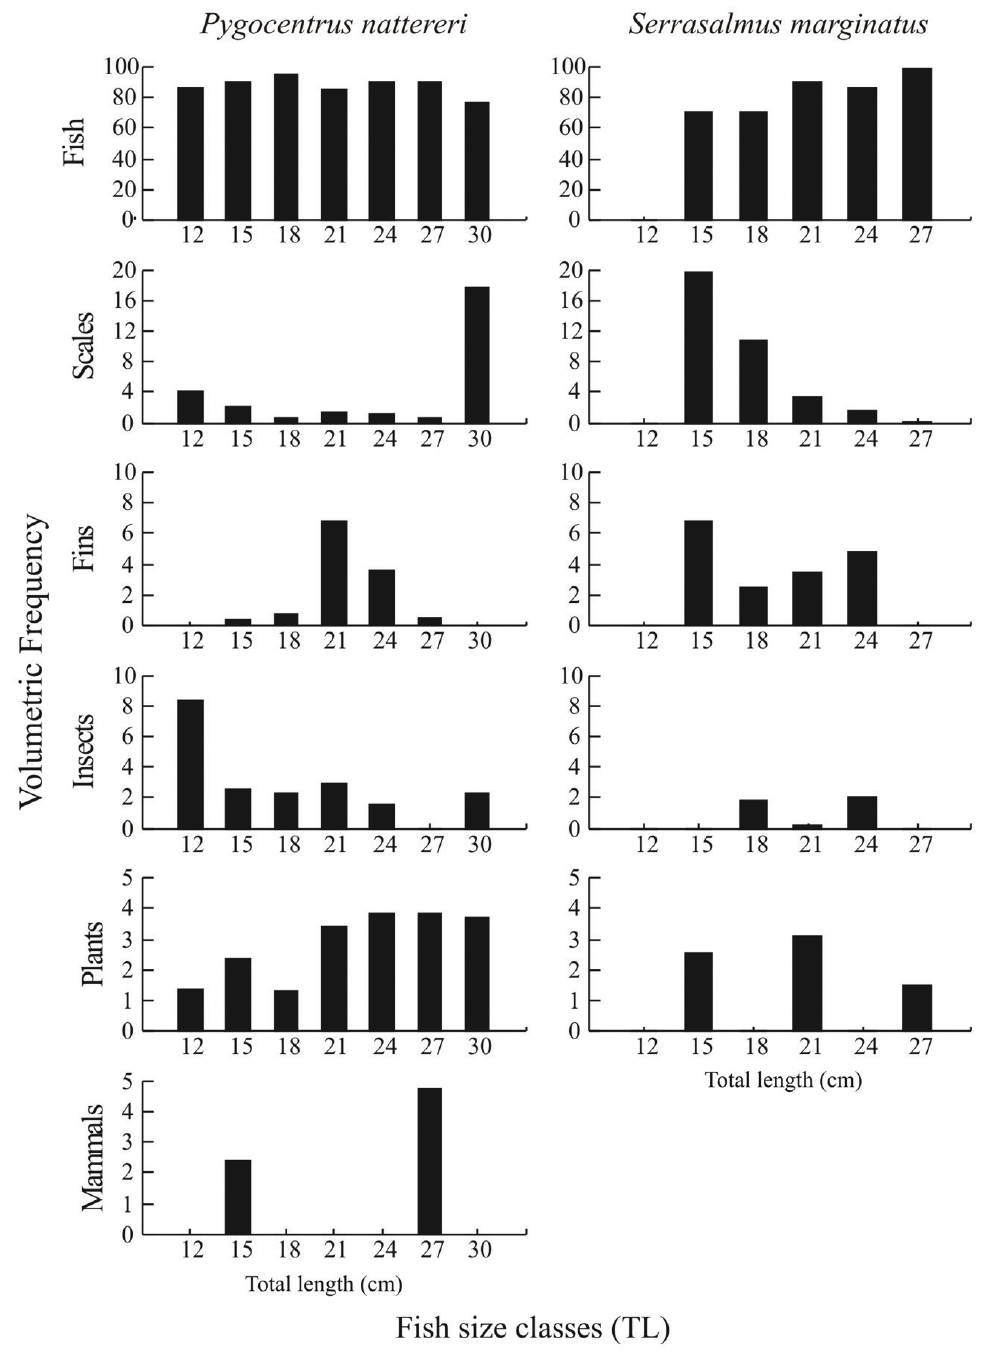
Figure 3. Volumetric Frequency of food items by classes of total length of Pygocentrus nattereri and Serrasalmus marginatus caught in the Negro River, Nhecolândia region, Pantanal, from October 2005 through August